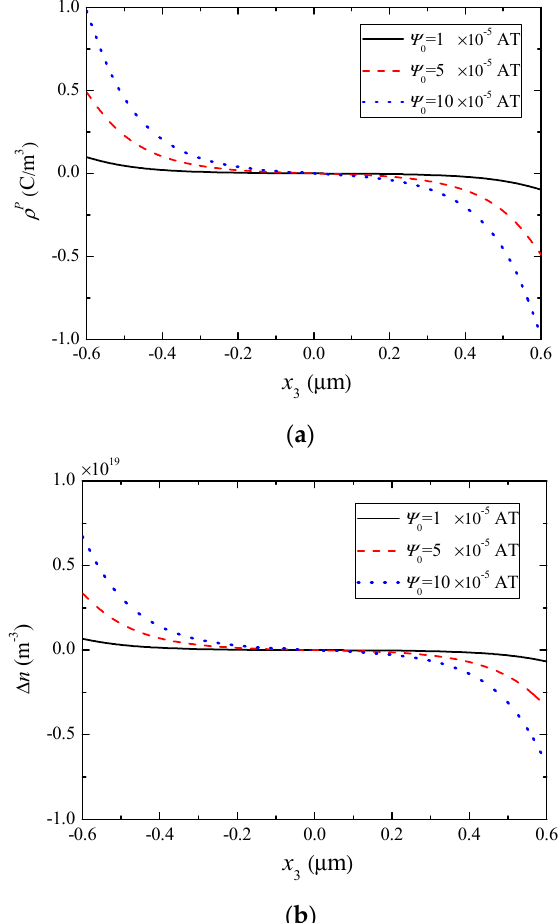
ψ when 21 3 =1 10 m n × . ( a ) 0 0